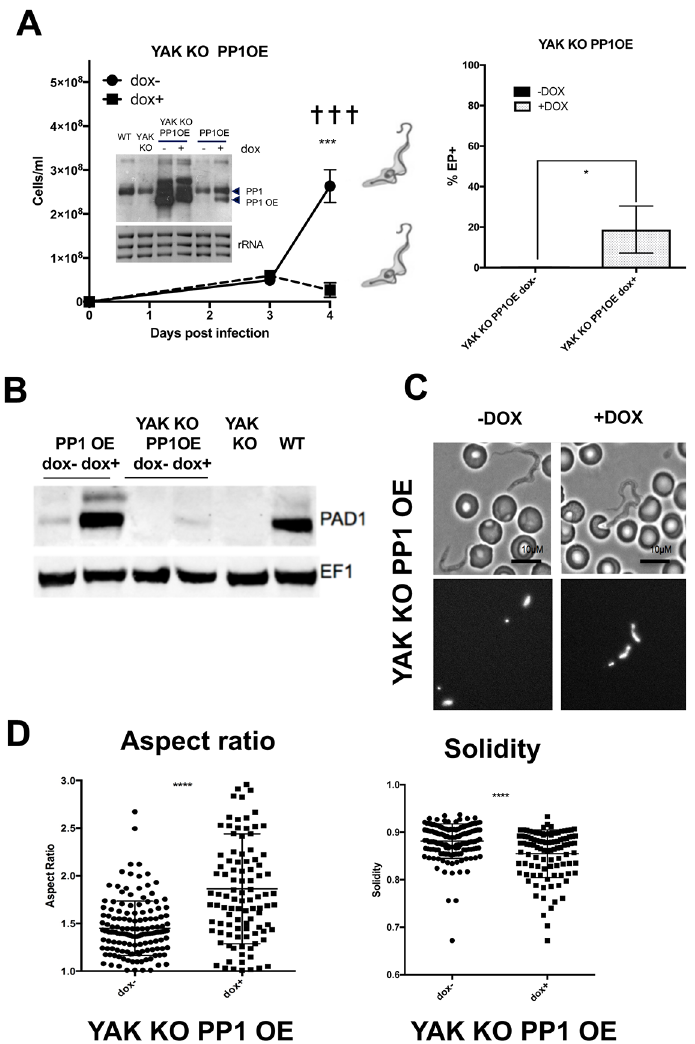
Fig 5. Cytological characteristics of YAK null mutants induced to ectopically express PP1. A. Inducible ectopic expression of PP1-6 in T . brucei EATRO 1125 AnTat1.1 90:13 YAK null mutants ( ■ , +dox; ● , -dox); ( (cid:3)(cid:3)(cid:3) p < 0.0005). The dominant morphology of the cells on day 4 is shown schematically. The inset northern blot shows PP1 transcript levels in the induced and uninduced cells; rRNA is the loading control. The right panel shows the expression of EP procyclin 4 hours after parasites were harvested on day 4 of infection and incubated in 6mM cis aconitate ( (cid:3) p < 0.05). B. Western blot of PAD1 expression in parental parasites (WT), YAK null mutant ( YAK KO) cells, or in parental cells (‘PP1 OE’) or in the null mutant (YAK KO PP1 OE) induced (+dox) or not (-dox) to ectopically express PP1-6. The YAK null mutant does not express PAD1 upon PP1-6 ectopic expression. C. Morphology of YAK null mutants induced (+dox) or not (-dox) to express PP1-6. A DAPI stained image of the cells (lower two panels) is also shown to highlight the aberrant nuclear morphology of induced cells with PP1-6 expression. Bar = 10μm. D. Analysis of the aspect ratio (left panel) and solidity (right panel) of YAK null mutants induced (+dox), or not (-dox) to express PP1-6. ( (cid:3)(cid:3)(cid:3)(cid:3) p < 0.00005). vitro , the inducible expression of NEK17 in the parental T . brucei EATRO 1125 AnTat1.1 90:13 background prevented population growth (S5A Fig). When the same assay was carried out in the RBP7AB null mutant, however, the parasites grew as well as uninduced parasites (S5B Fig) despite the effective expression of NEK17, which was at higher level than in the parental background (S5D Fig, left panel). In contrast, when examined in a YAK null mutant